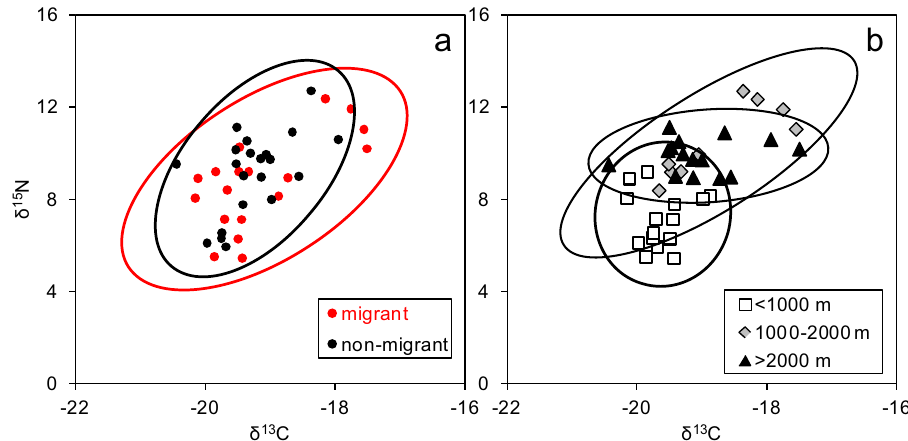
Figure 1. Plot of bulk δ 15 N and δ 13 C grouped by migratory ( a ) or depth layer distribution characteristics ( b ). The ellipses encompassing 95% of data for each group are indicated.